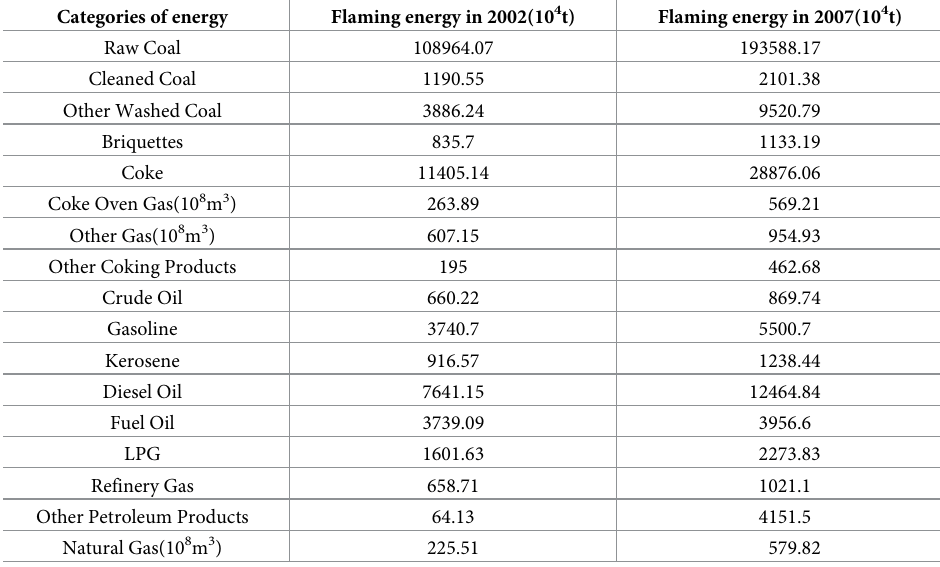
Table 1. Energy use of China in 2002 and